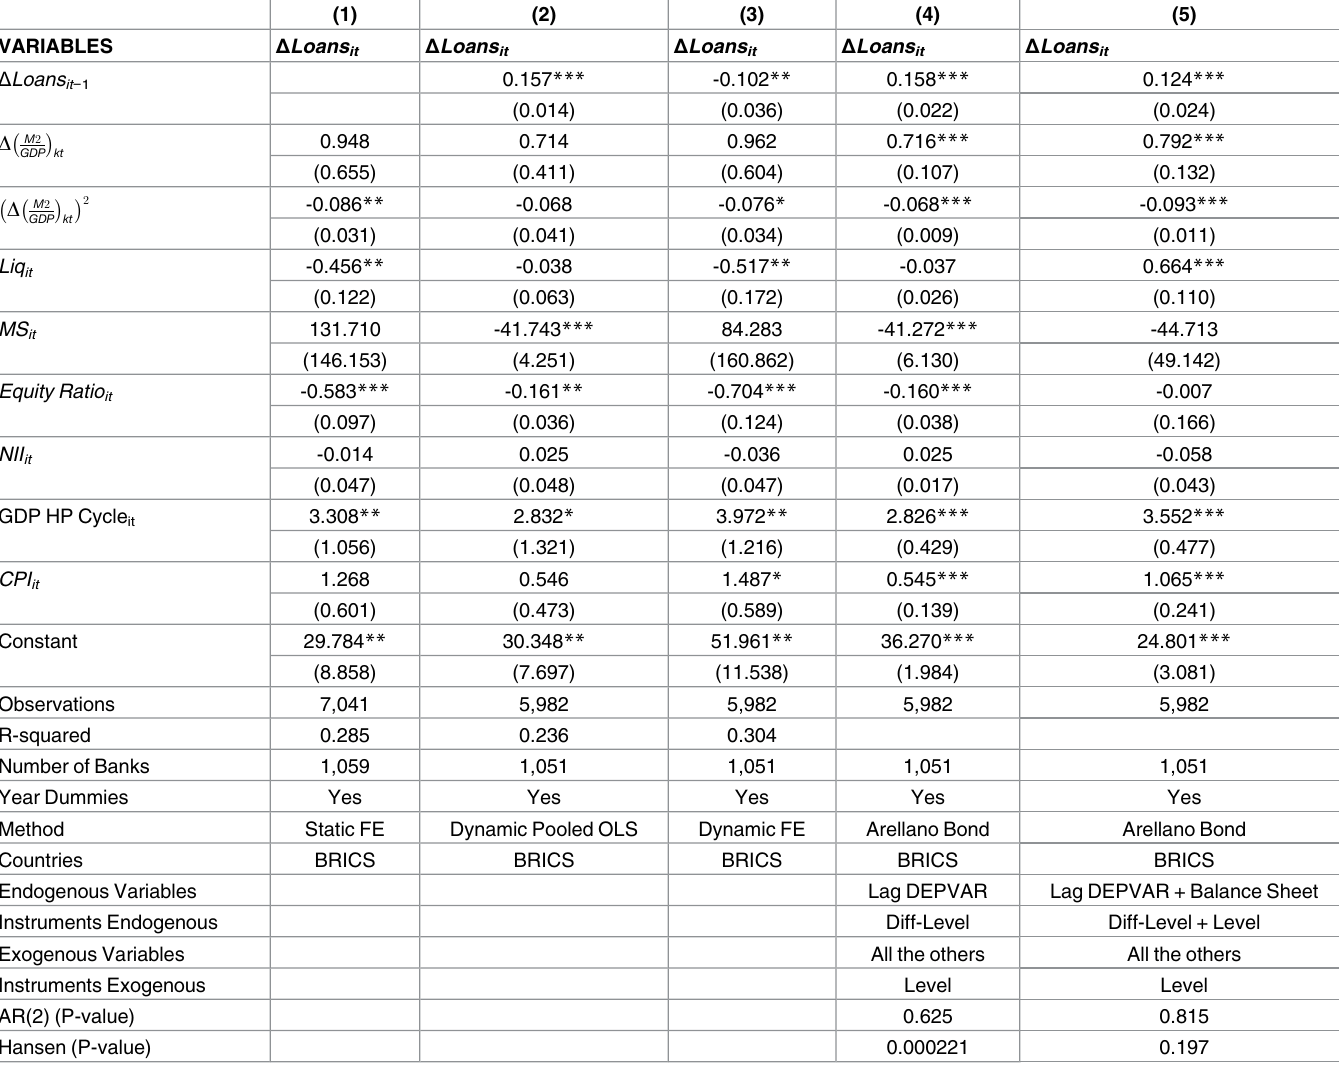
Table 3. Regression of Bank’s Loan Growth on Monetary Expansion D M2